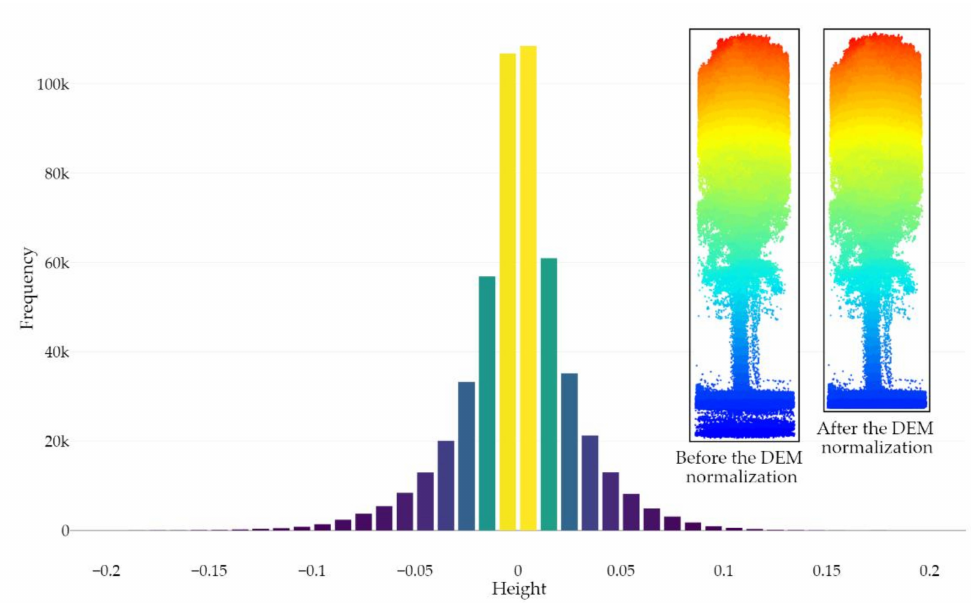
Figure 5. Histogram of ground points’ height (bins of 0.01 m) after the DEM normalization using the point cloud acquired during the leaf-on season and a 75 ◦ MSAR. The removal of falsely located underground points (i.e., with a negative height value) is illustrated for a single tree (leaf-off season and 75 ◦ MSAR) on the right side of the figure.